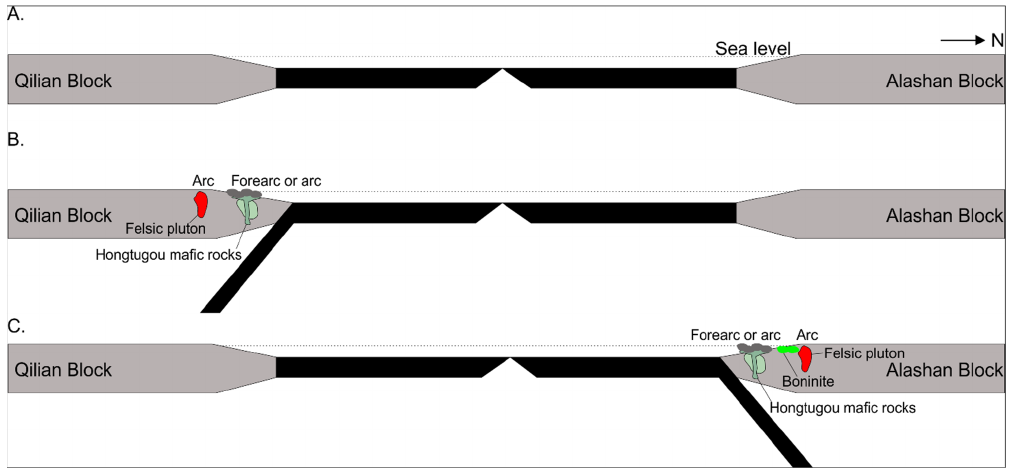
Figure 12. Tectonic evolution of the NQOB to illustrate a continental convergent margin setting for mafic rocks in the present study. (A) Stage I: Qilian Ocean spreading (ca 710–520 Ma), (B) Stage II ‐ Hypothesis one: Southward subduction (ca. 507 Ma), and (C) Stage II ‐ Hypothesis two: Northward subduction (ca. 507 Ma). The ages for Qilian Ocean spreading are from Song et al. (2013) [16].